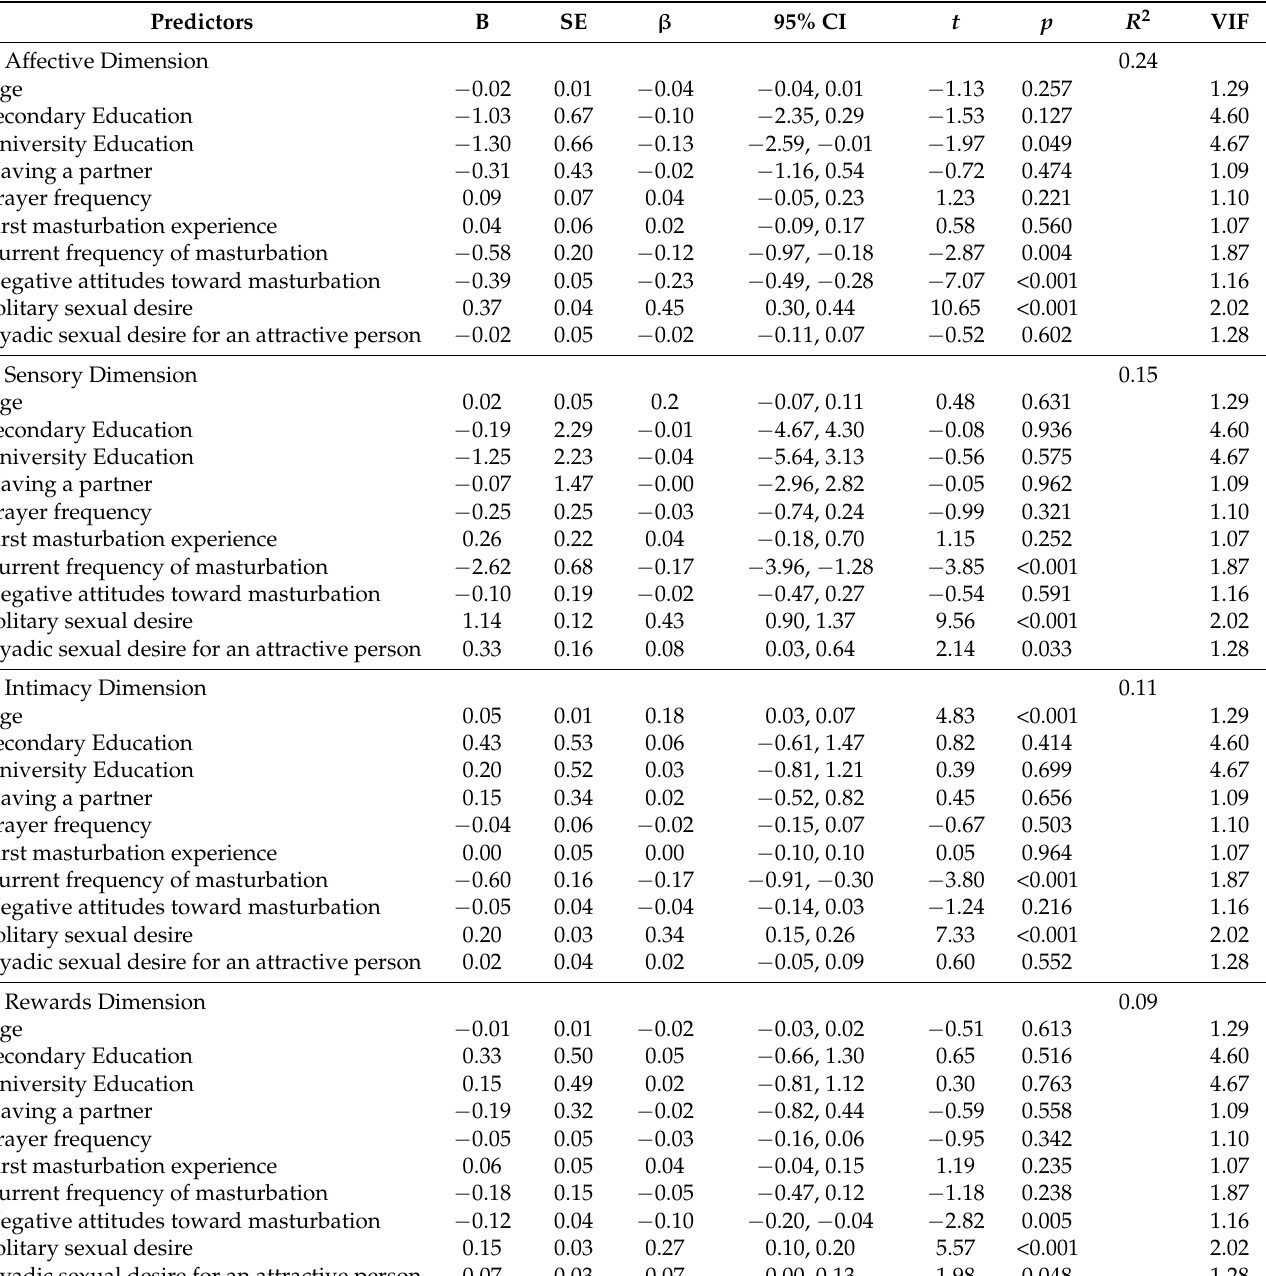
Table 3. Multiple linear regression models for the four dimensions of the subjective orgasm experience in